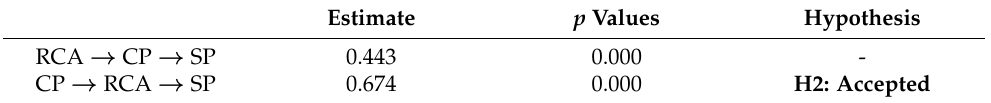
Table 8. Indirect and moderating effects results. Estimate p Values Hypothesis RCA → CP → SP 0.443 0.000 - CP → RCA → SP 0.674